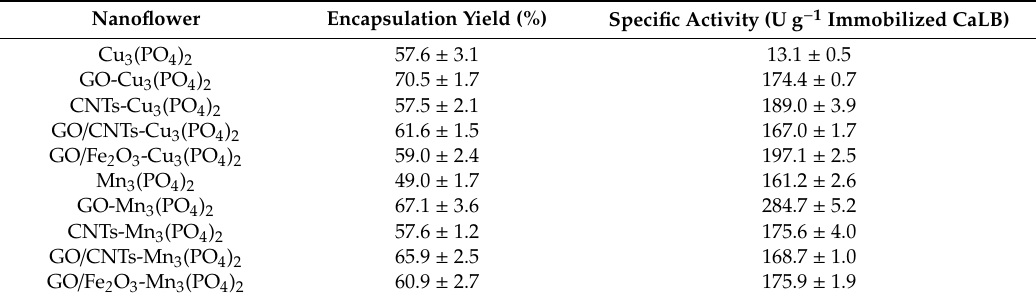
Table 2. Encapsulation yield and specific hydrolytic activity of various